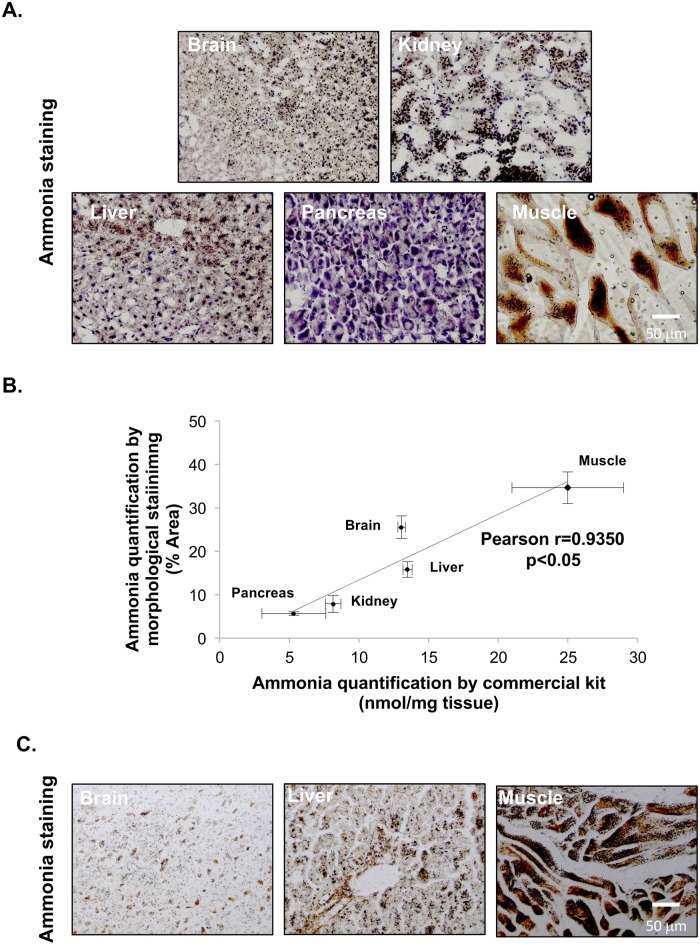
Representative micrographs of ammonia staining in healthy mouse tissue.Representative micrographs of ammonia staining in healthy mouse tissues in samples included in O.C.T (A) and Pearson correlation of the quantification of ammonia in biological tissues between the novel proposed method and the commercial available colorimetric kit (B). Representative micrographs of ammonia staining in healthy mouse tissues in samples included in paraffin (C). At least triplicates were used for each sample.